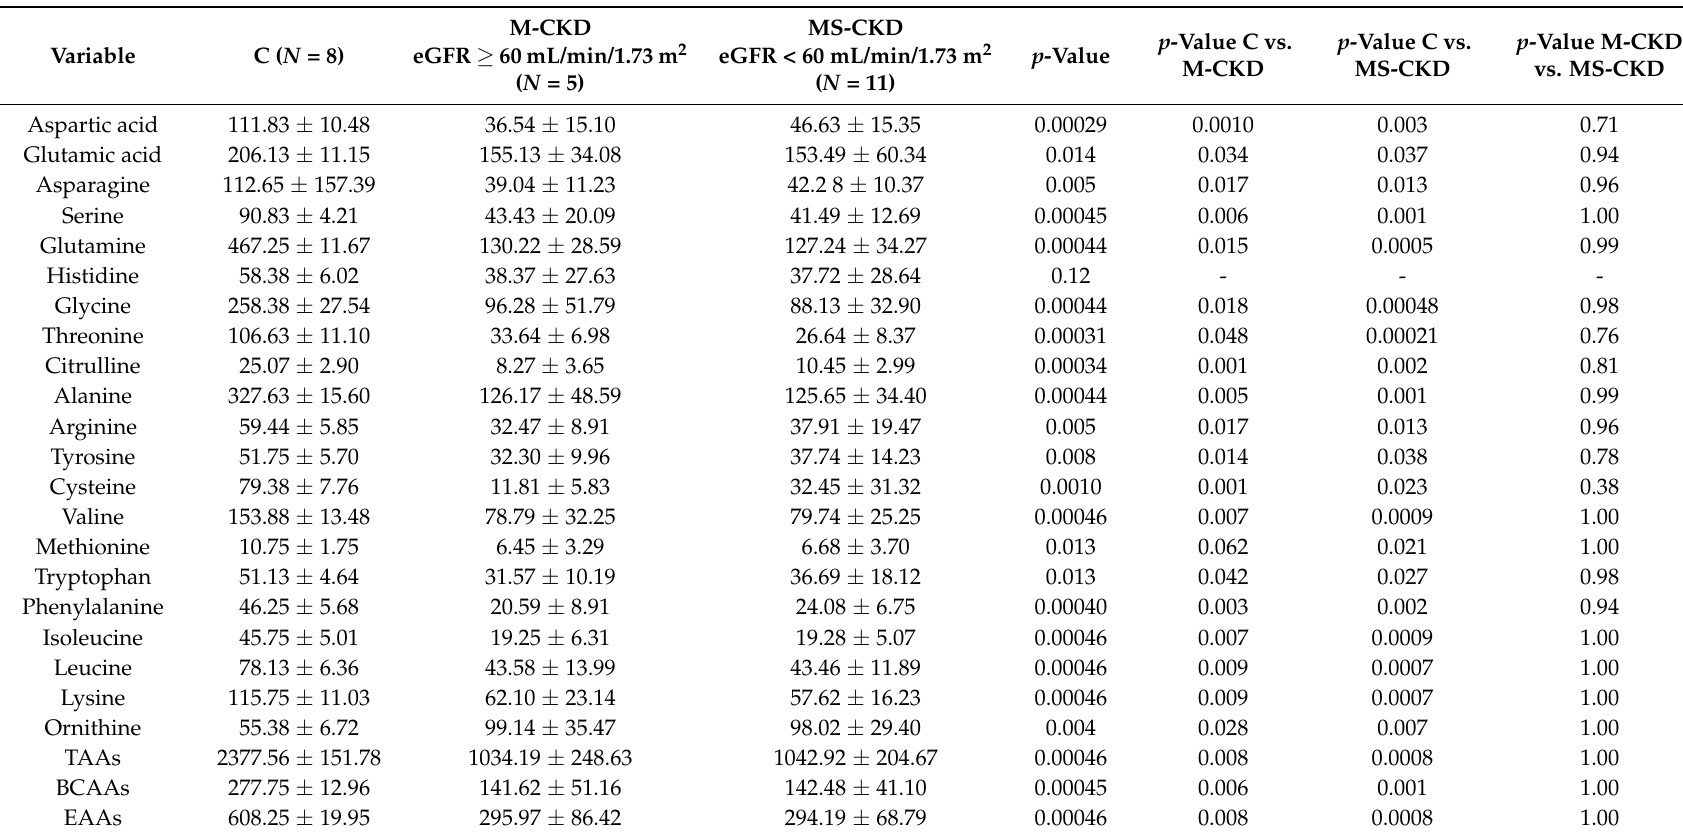
Table 7. Plasma venous AA concentrations ( µ mol/L) in controls (C) and cardiorenal syndrome type 2 (CRS 2) patients after stratification for eGFR ≥ 60 mL/min/1.73 m 2 (mild CKD: M-CKD) and eGFR < 60 mL/min/1.73 m 2 (moderate-severe CKD: